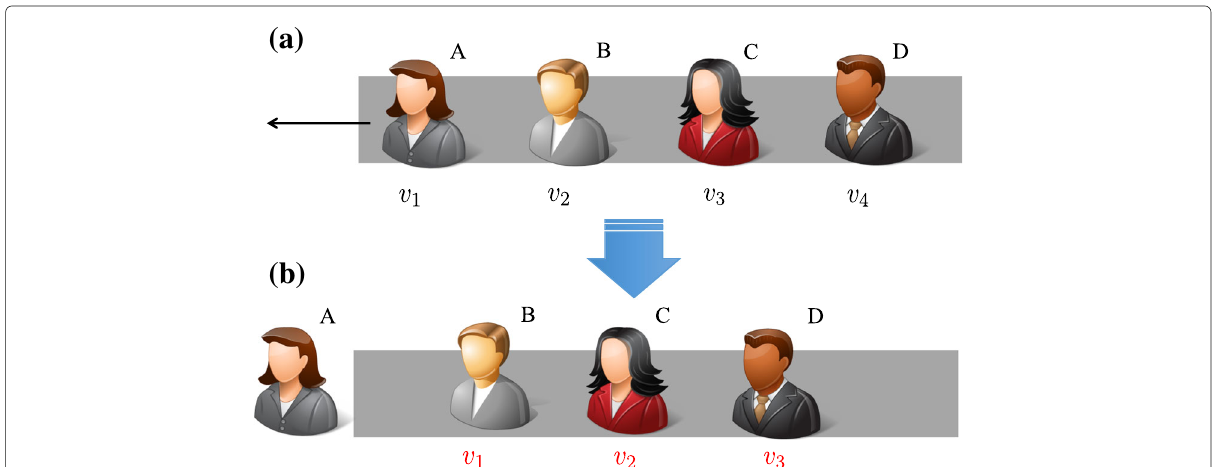
Fig. 2 Evacuees’ moving speed model. a A situation where four evacuees, A, B, C, and D, move in the same direction on a road and b the situation just after evacuee A leaves the